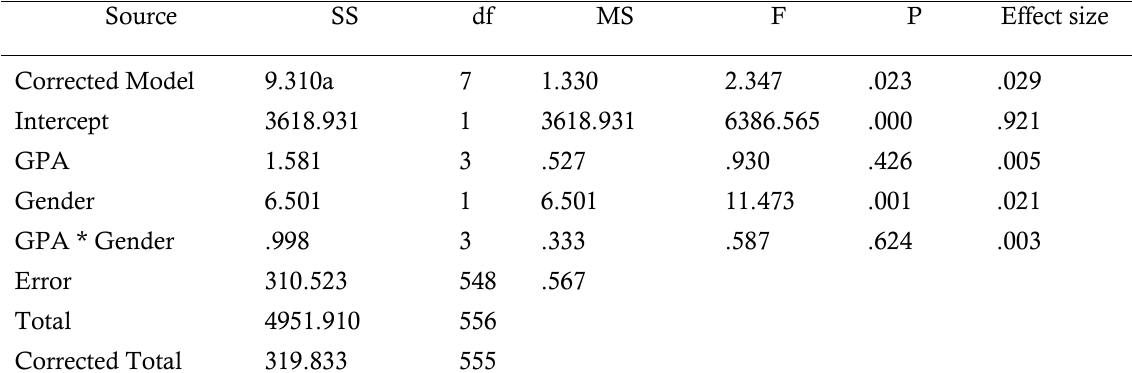
Table 5. Univariate Analysis of the effect of gender, grade and GPA on alexithymia .